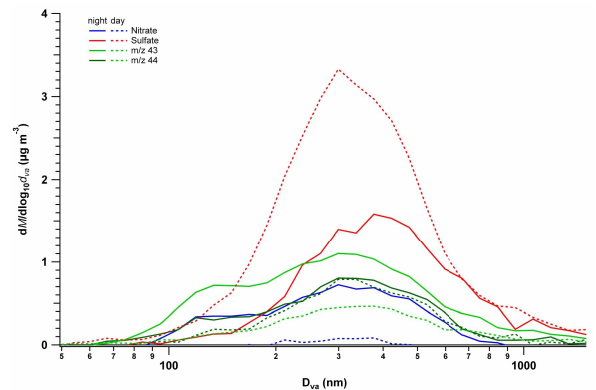
Fig. 5. An example of a typical summer night and day particle size distribution as measured on 7 June 2008. Night referred from midnight to 04:00 and day from noon to